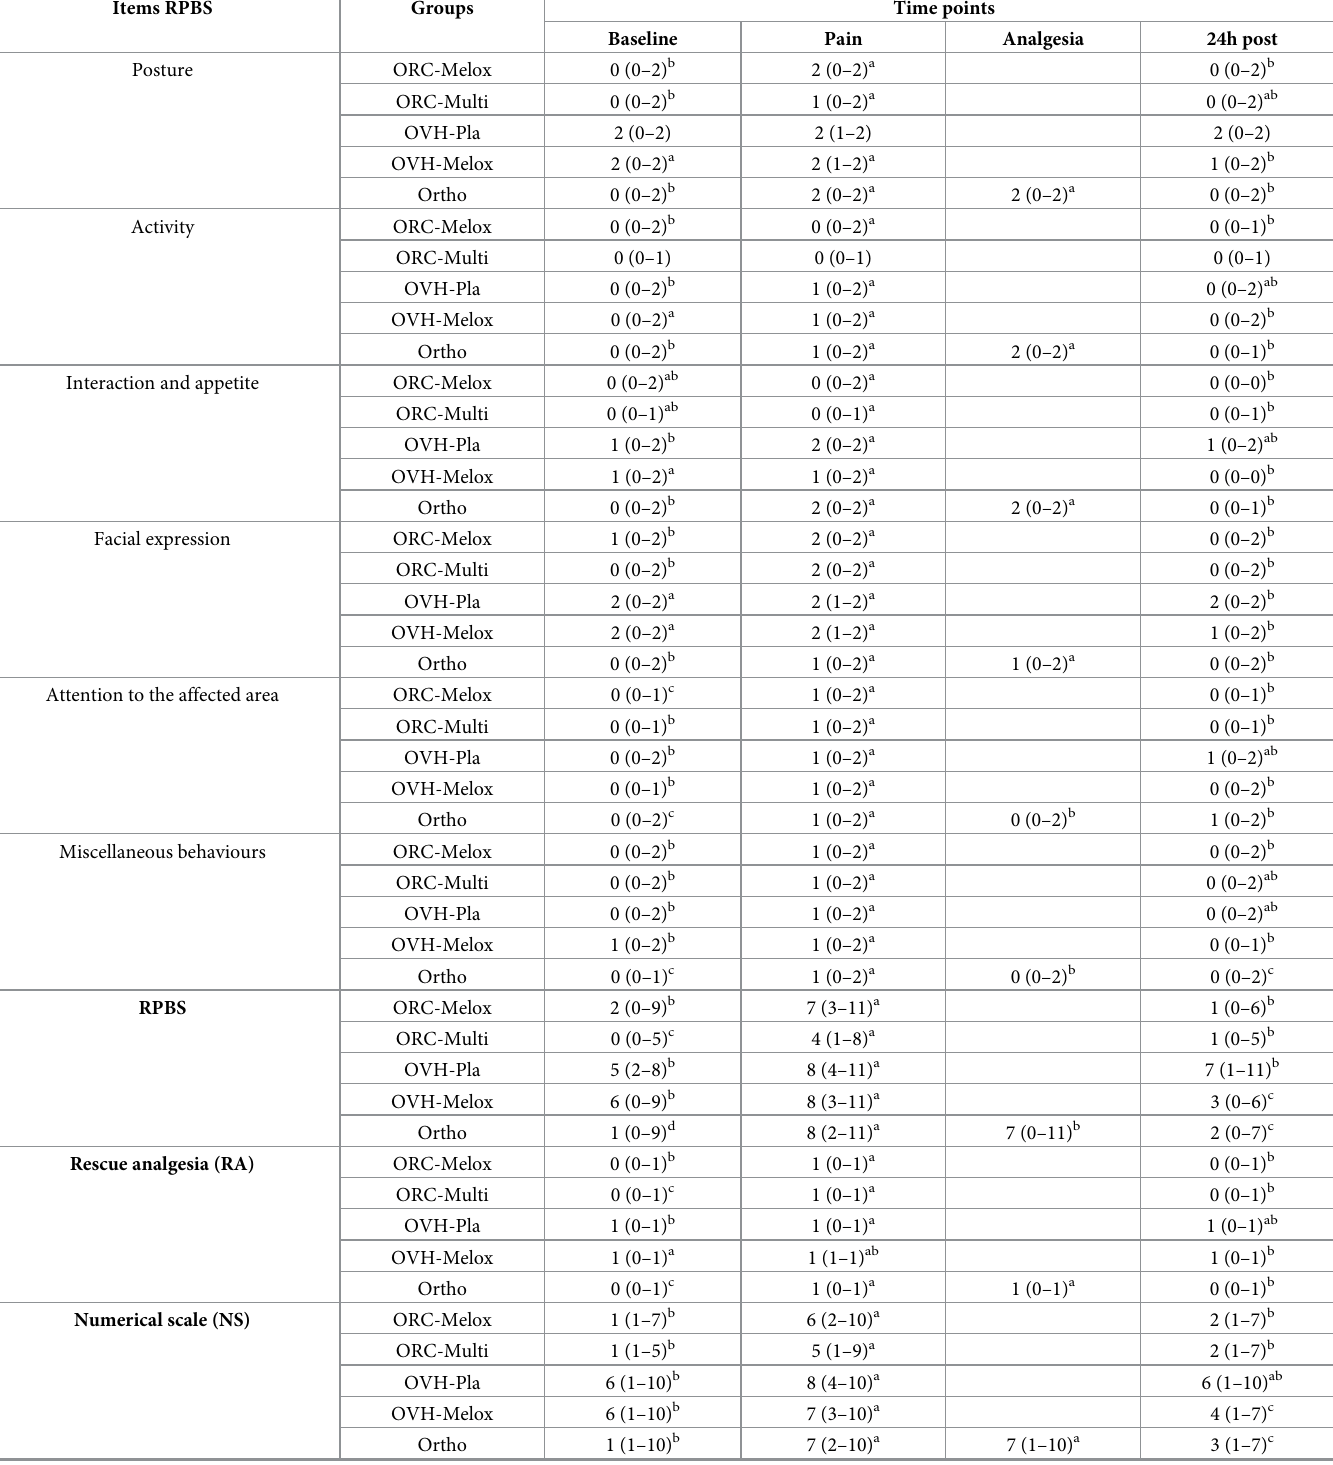
Table 8. Pain scores of the RPBS, rescue analgesia, and unidimensional pain scales between the time points evaluated for each